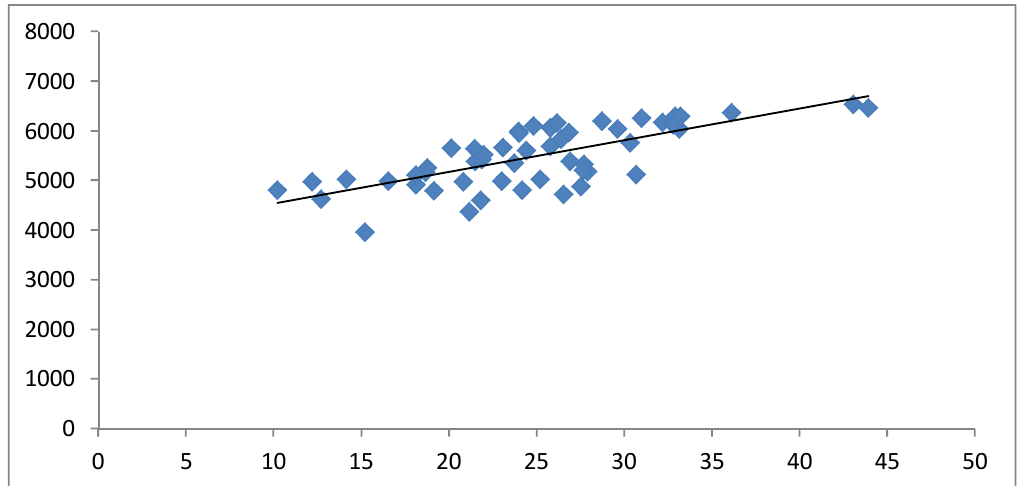
Figure 3: Relation between PCGDP & Cap formation (%gdp) during